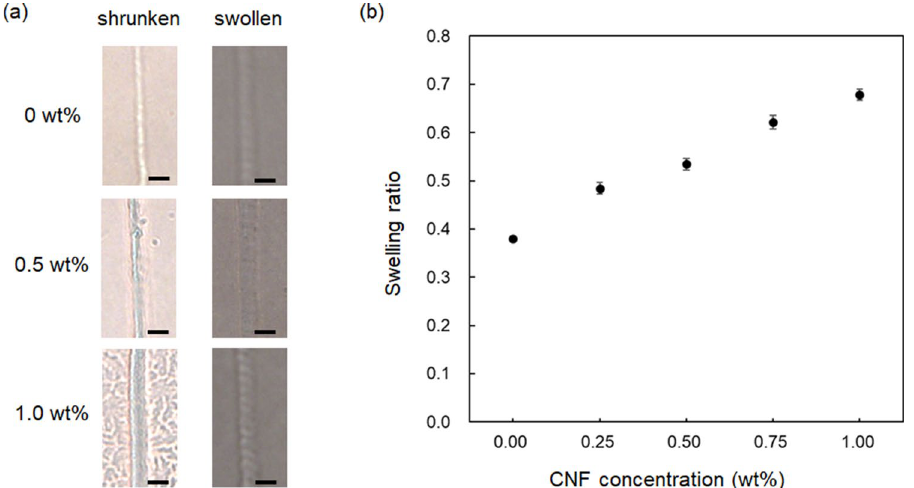
Figure 8. ( a ) Optical microscope images of the CNF/PEGDA composite microstructures in shrunken and swollen states fabricated at different CNF concentrations. Scale bars indicate 5 µm. ( b ) Dependence of swelling ratio of the microstructure on the CNF concentration. The swelling ratios were measured at five locations, and the average value was plotted with the standard